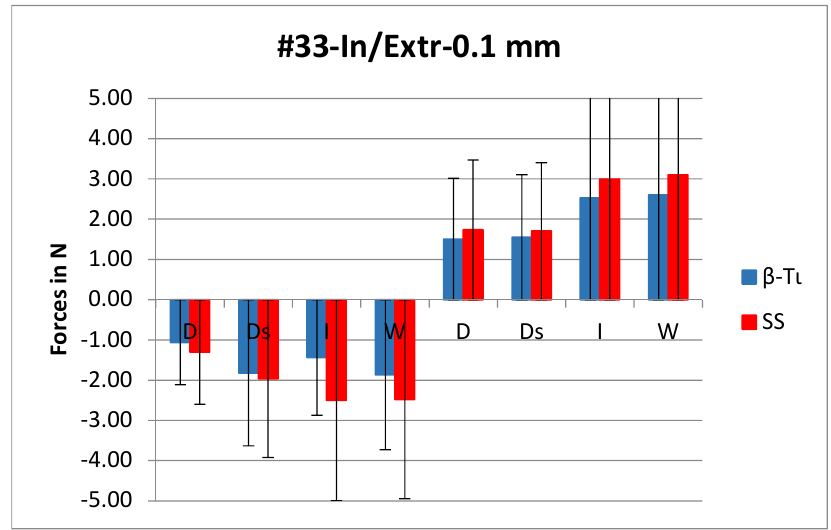
Figure 2. Graphic representation of the forces generated at 0.1 mm of the intrusion and extrusion of the canine (#33). SS: stainless steel; β-Τi: beta titanium; D: discovery® MIM; Ds: discovery® smart; W: WiN; I: Incognito™; N: Newton.